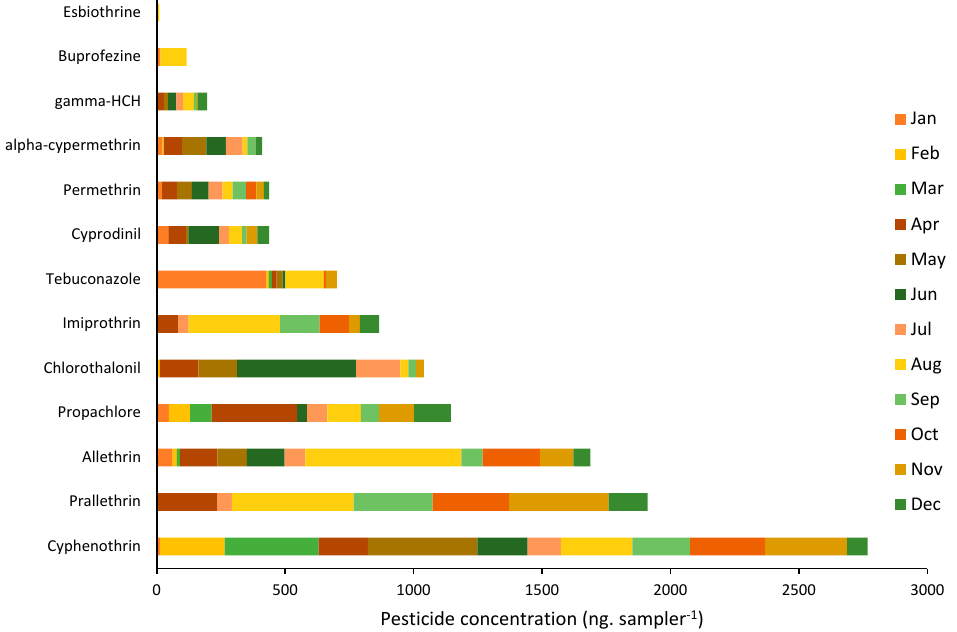
Figure 4. Variation of the concentration of pesticides detected in the air samples collected from the bedrooms of the targeted houses during the one-year sampling campaign (data are shown as per average concentration of pesticides detected in the nine residences per month).